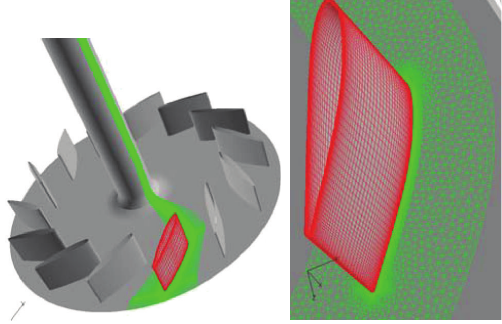
Figure 5: Gridding for the impeller B#1.